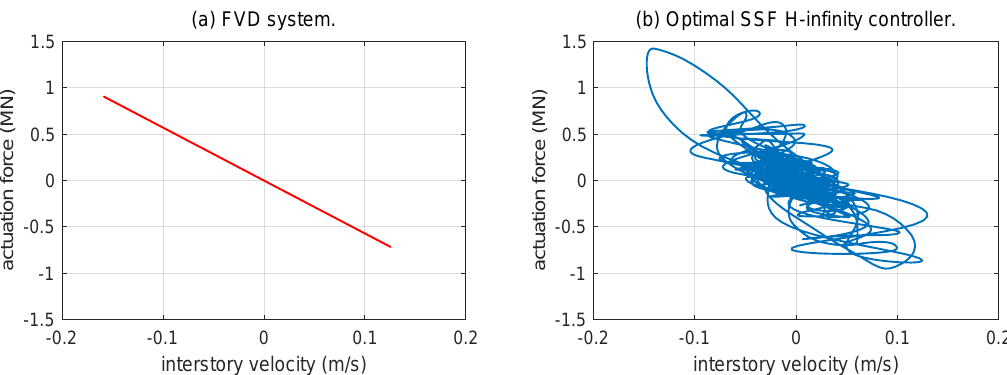
Figure 11. Plots of actuation force versus interstory velocity in the 3rd story level corresponding to the FVD system and the optimal SSF H ∞